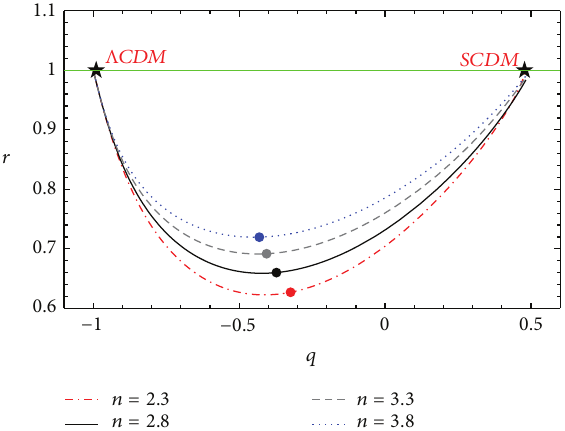
Figure 8: The statefinder plot for NADE in 𝑞 − 𝑟 plane. The green line represents the Λ CDM with −1 ≲ 𝑧 ⩽ 2